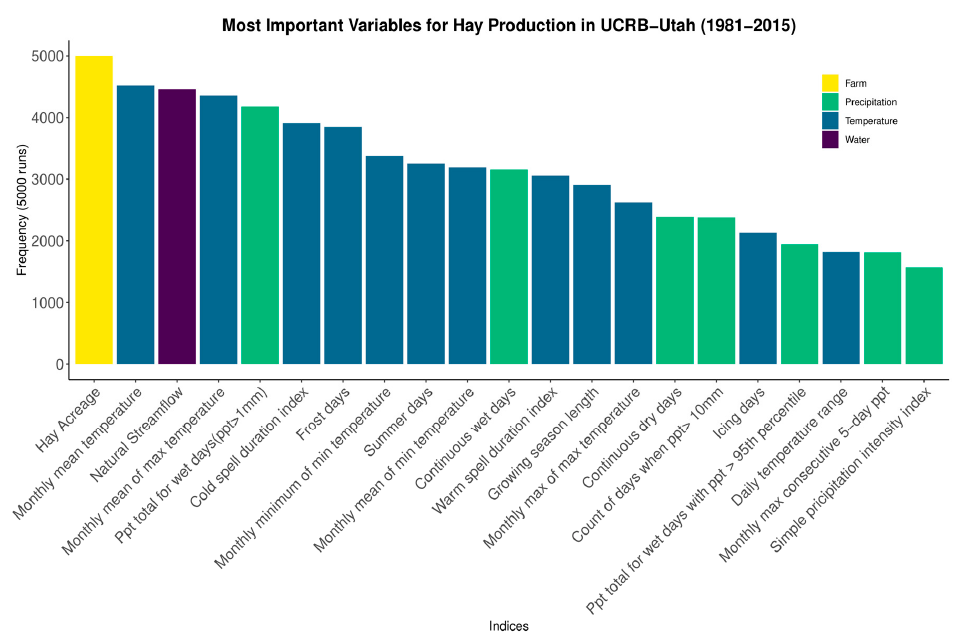
Figure 7. Most important variables for hay production in UCRB-Utah (random forest regression, RFR).